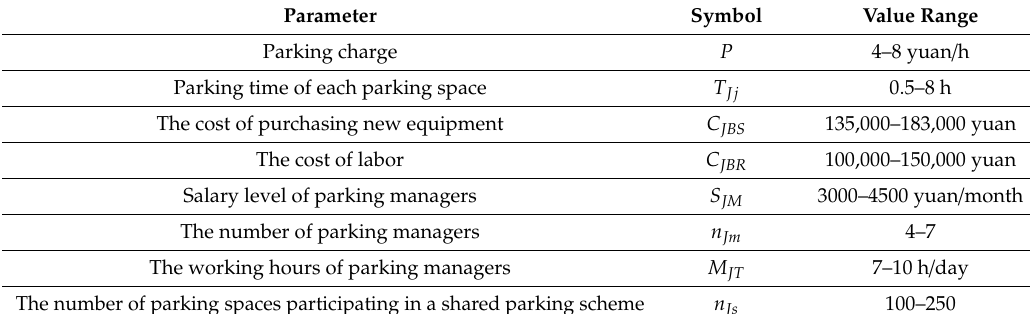
Table 2. List of